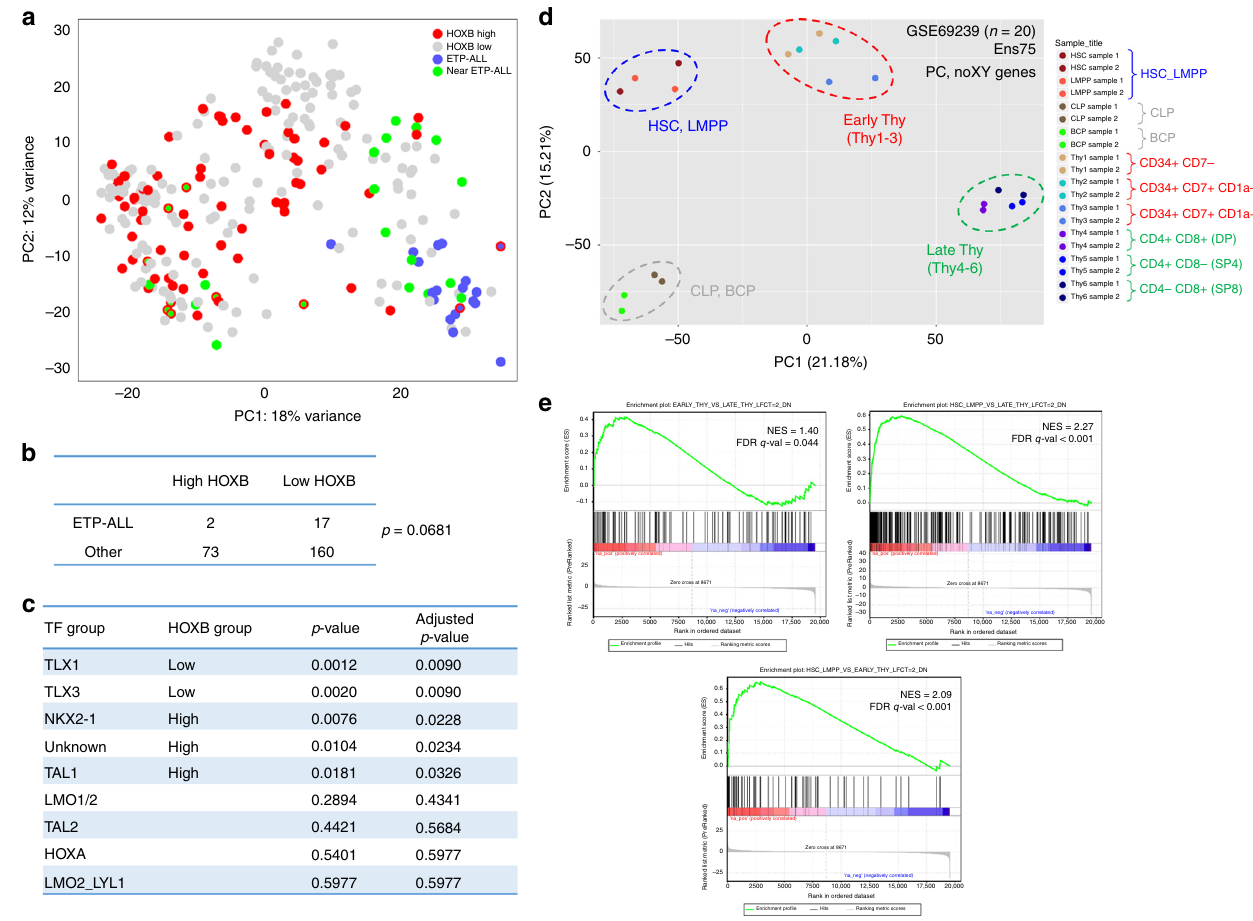
Fig. 7 High HOXB gene expression de fi nes a distinct disease subgroup in human T-ALL. a Principal component analysis (PCA) of RNA-seq data from 252 patient T-ALLs (COG TARGET study; dbGaP phs00018/000464). HOXB (high and low), ETP-ALL, and near ETP-ALL subgroups are highlighted. b , c Correlation between HOXB subgroups and ( b ) ETP-ALL or ( c ) transcription factor/genetic subgroups among 252 patient T-ALLs (COG TARGET study; dbGaP phs00018/000464). Statistical p values were calculated by Fisher ’ s exact test and adjusted for multiple testing by the Benjamini − Hochberg procedure. d PCA of RNA-seq data from normal human bone marrow and thymic progenitor cells (GEO GSE69239). All protein coding genes (X/Y chromosomes excluded) were utilized for PCA. Samples were partitioned into four groups (HSC/LMPP, CLP/BCP, Early Thy = Thy1/2/3, Late Thy = Thy4/5/6) based on the PC1 and PC2 dimensions. e Gene set enrichment analysis (GSEA). Depicted gene signatures were derived by differential expression analysis of HSC/LMPP vs. early thymic vs. late thymic progenitors using a log2 fold-change (FC) threshold of 2. All protein coding genes